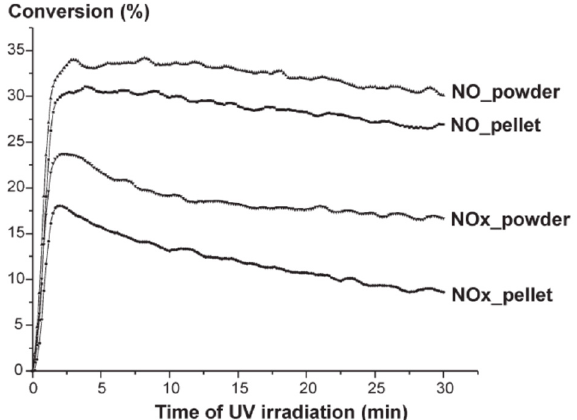
Figure 24. Comparative decrease of the NO x removal performed on TiO 2 in the form of powder and pellets (plane surface, 54 cm 2 ). Reproduced with permission from Toma et al. [108]. Copyright 2004 by Springer-Verlag (License No.: 4453250060579).